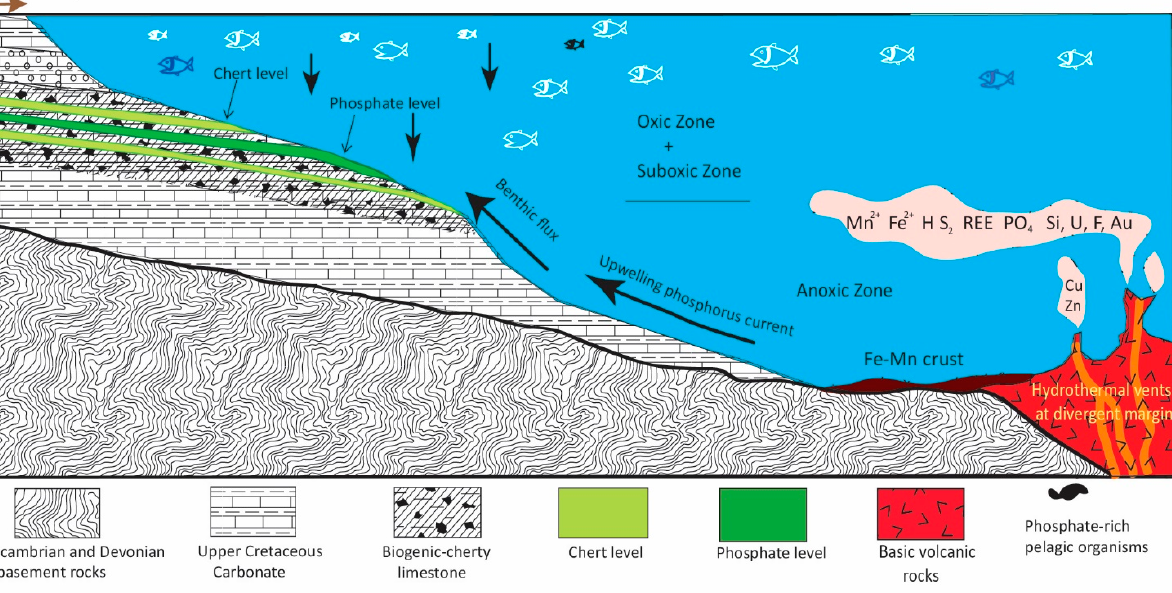
Figure 12. Simplified model of the depositional environment of Maz ı da ğ ı phosphates.